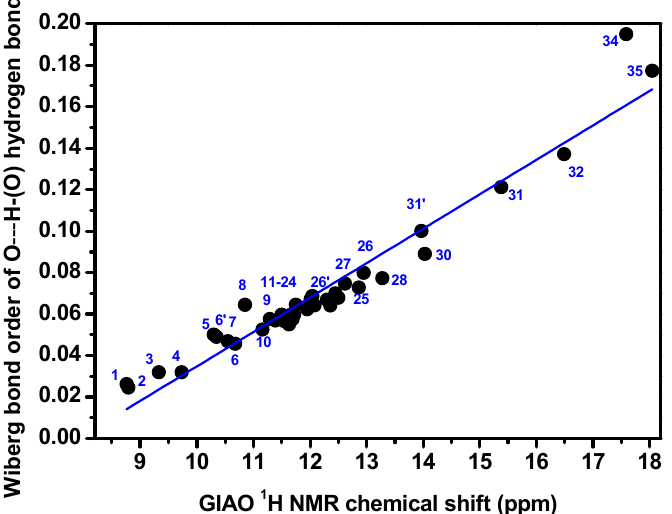
Figure 16. Plot of calculated Wiberg bond order of the intramolecular O ··· H(O) hydrogen bond of the compounds 1–35 of Scheme 3 vs. GIAO calculated 1 H chemical shifts. The minimization of the structures and the NBO analysis were performed at the M06-2X/6-31+G(d) level of theory. Adopted, with permission, from [47]. Copyright 2015, The Royal Society of Chemistry.